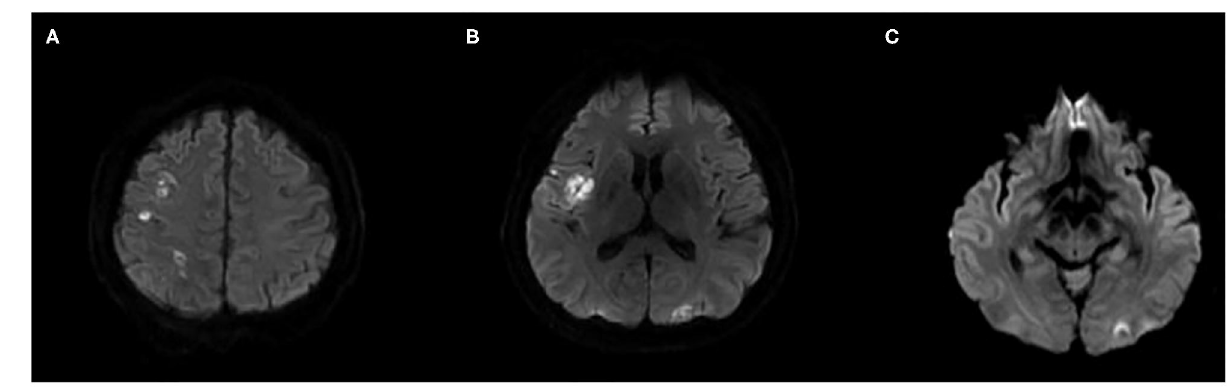
FIGURE 1 | Initial brain MRI. Diffusion-weighted imaging shows multiple scattered high signal intensity on the right insular, frontal, parietal, and left occipital cortices, suggestive of acute ischemic stroke (A–C)